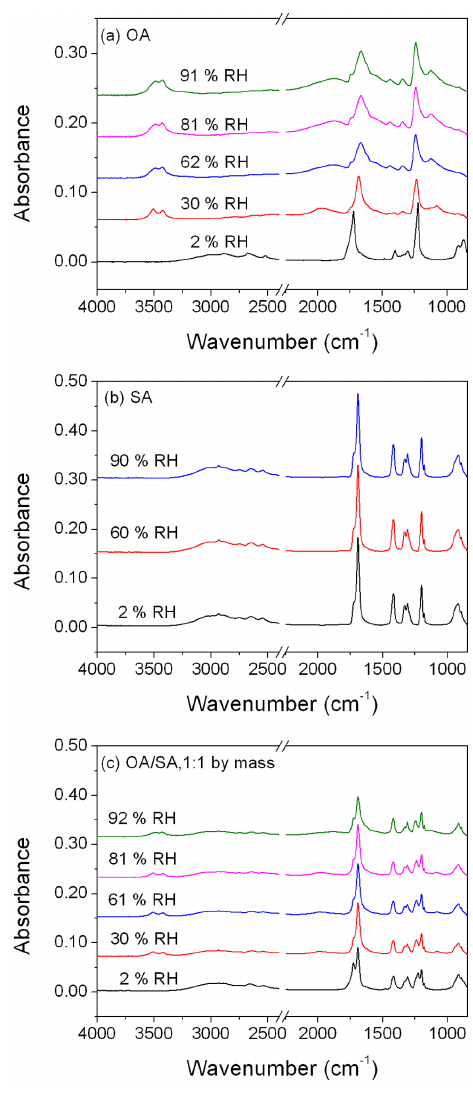
Figure 8. ATR-FTIR absorbance spectra of aerosol particles upon hydration with RH for (a) oxalic acid, (b) succinic acid, and (c) ox- alic acid/succinic acid mixture (1:1, by mass). Features from gas- phase water have been subtracted. Gas-phase CO 2 absorptions have been removed and the spectra have been offset for